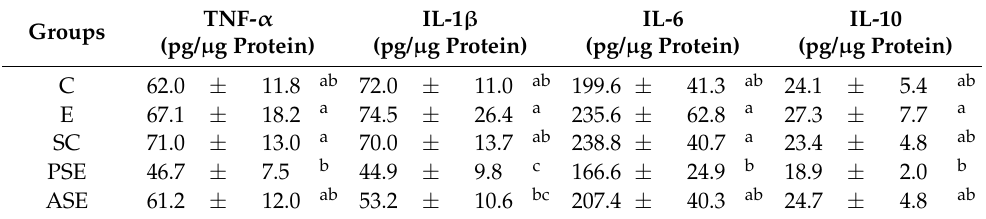
Table 4. Effects of synbiotics supplementation on hepatic cytokines in rats with chronic ethanol feeding 1,2 . Groups